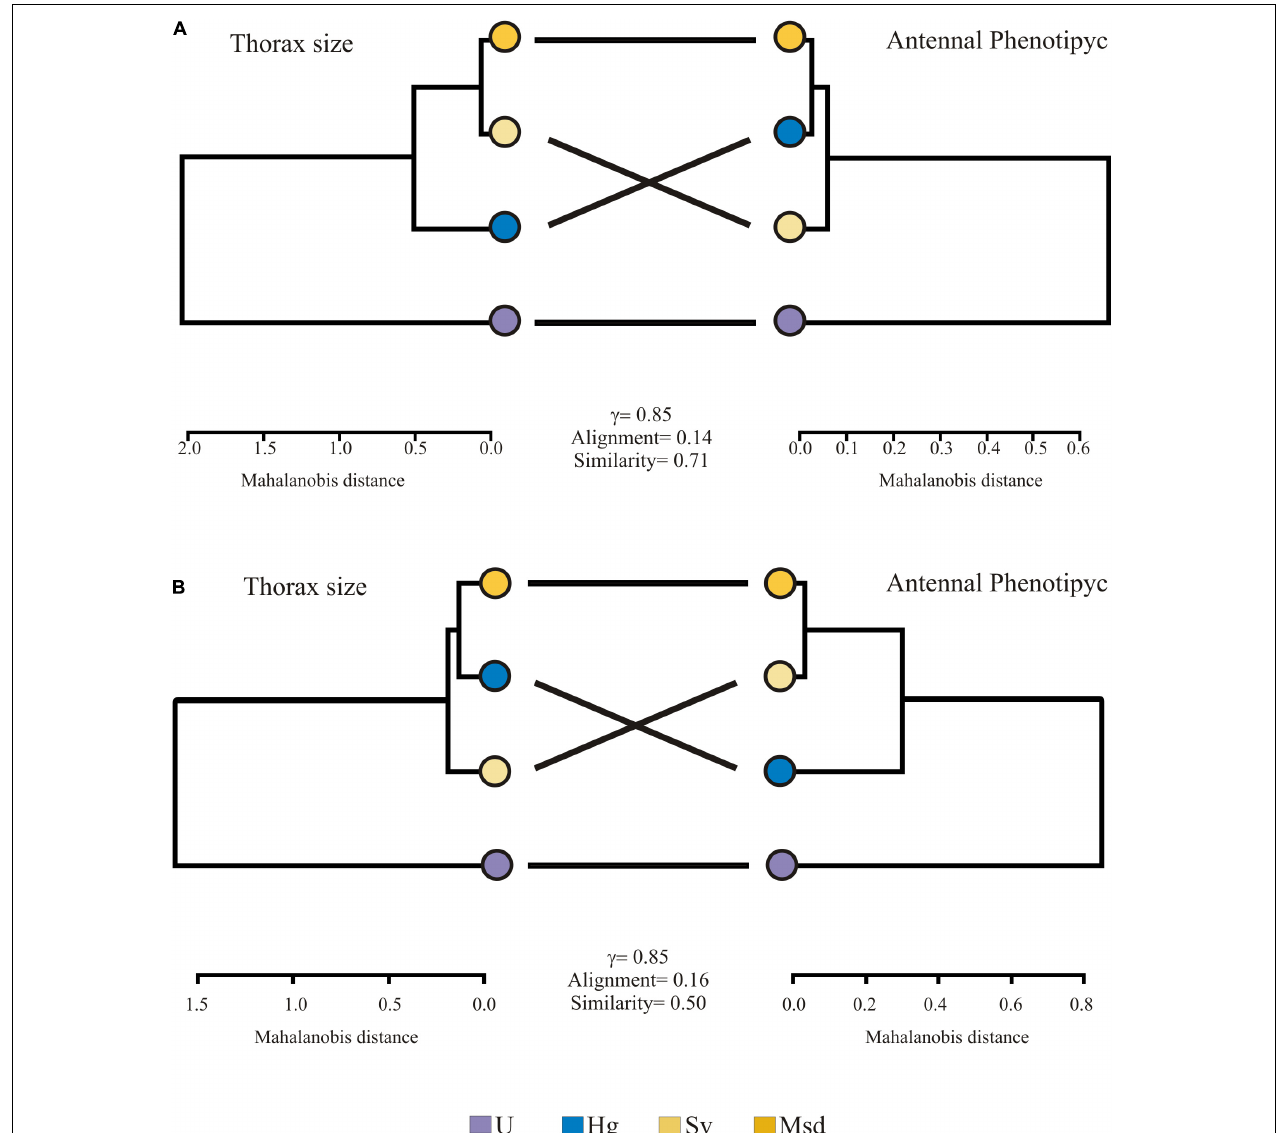
FIGURE 7 | Patterns of hierarchical similarities in thorax size (left) and antennal phenotypic (right) by landscape for T. dimidiata (A) female and (B) male. Landscape: Urban (U), Homegarden (Hg), Secondary vegetation (Sv), Median subdeciduous tropical forest (Msd) Goodman-Kruskal-gamma index ( γ ); Alignment quality